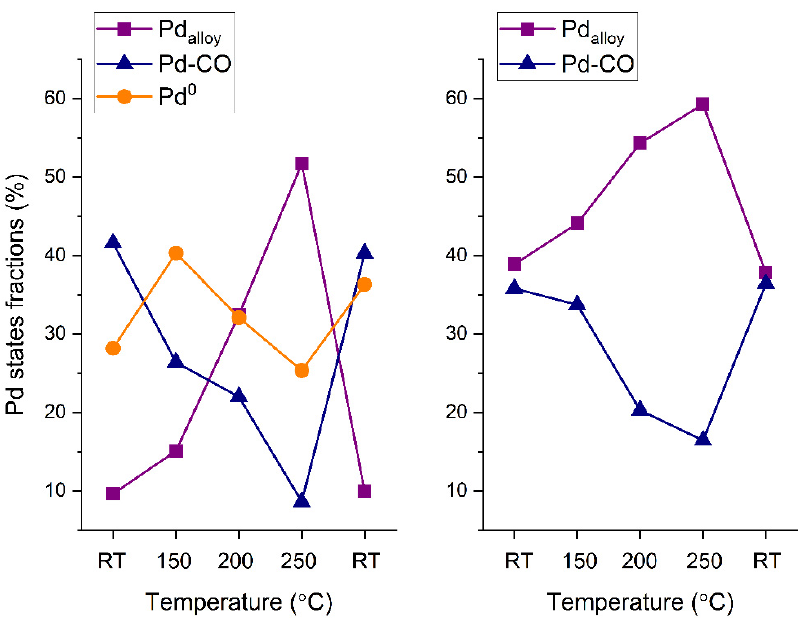
Figure 5. Fractions of different Pd states for the PdAu-1 ( left ) and PdAu-2 ( right ) samples in the reaction mixture (CO/O 2 = 2:1) as a function of temperature (calculated from XP spectra measured at the kinetic energy level of 300 eV).